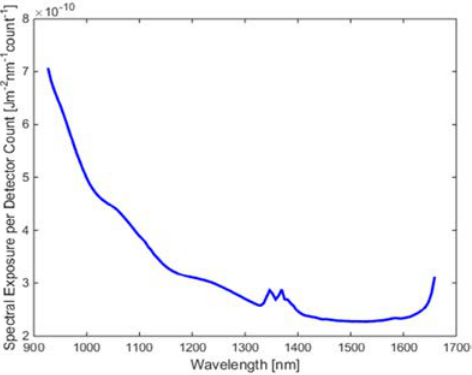
Figure 3. Conversion functions for FLAME-NIR